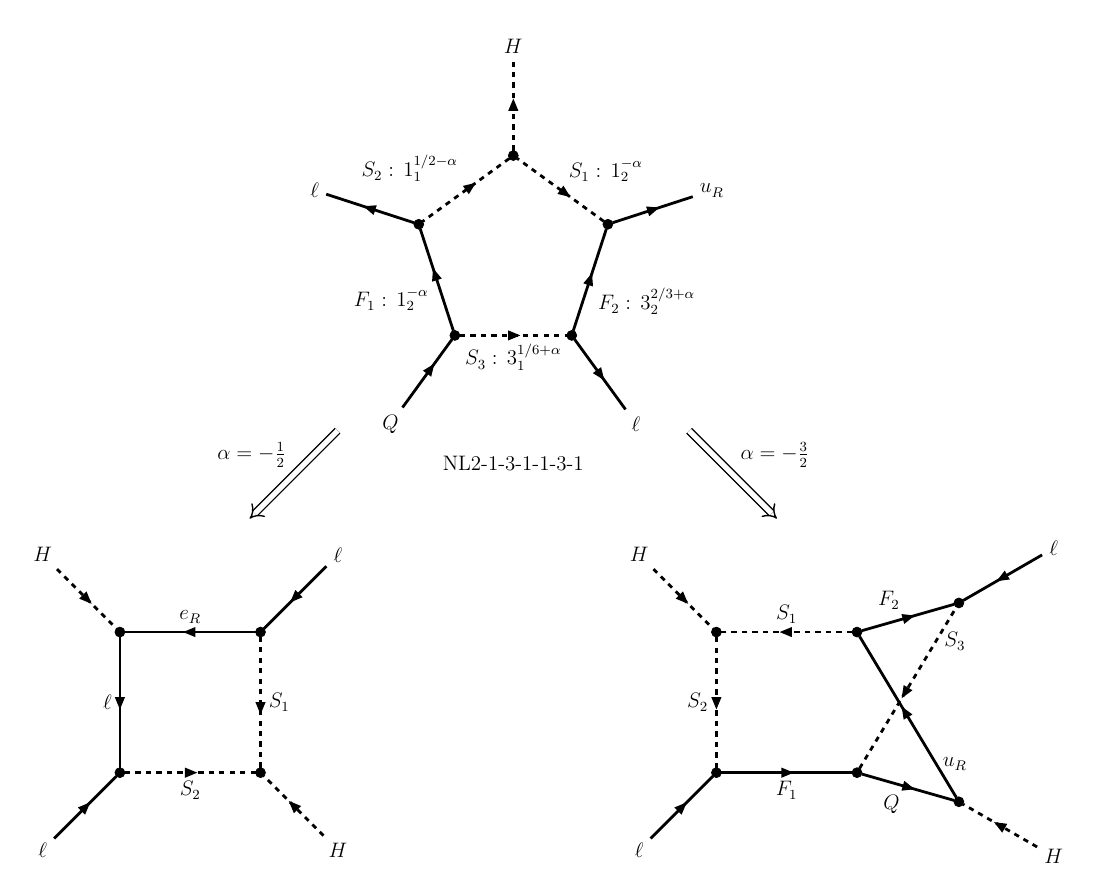
Figure 13 . The neutrino mass generation in the 0 νββ decay model NL2-1-3-1-1-3-1. One sees that the mechanism producing neutrino mass depends on the value of the hypercharge parameter α